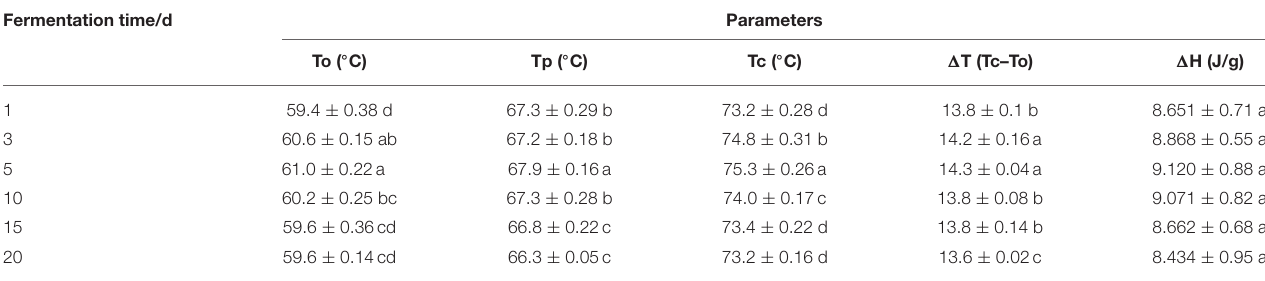
TABLE 4 | Effect of natural fermentation on the characteristic pasting parameters of corn ballast starch. Fermentation time/d